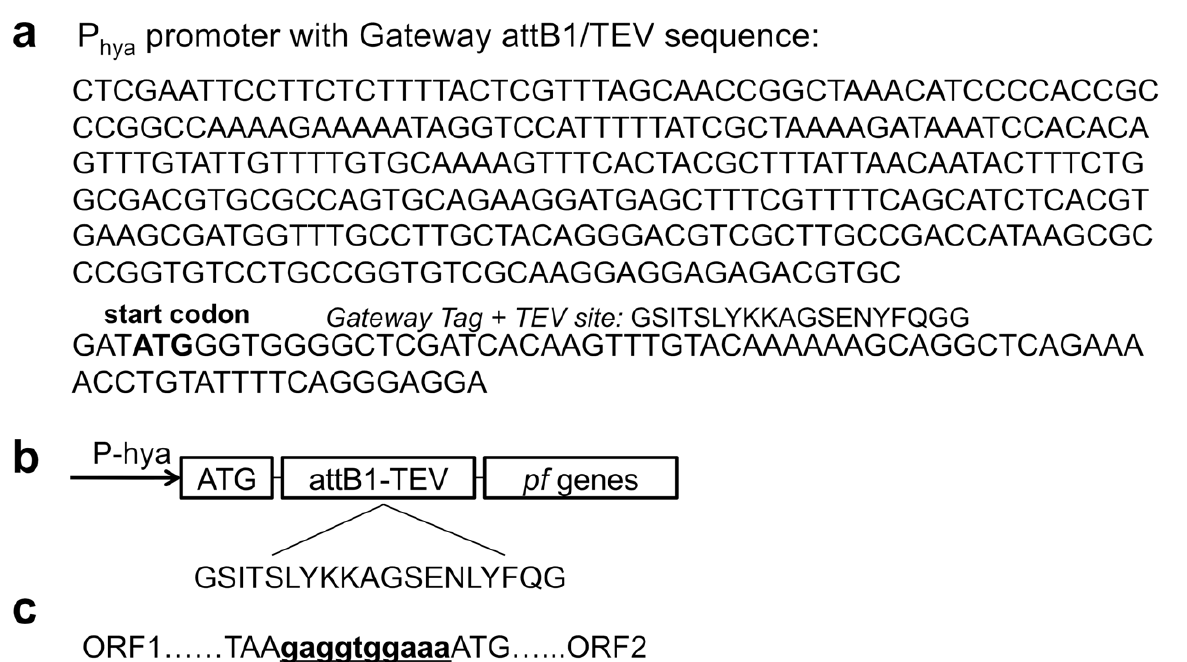
Figure 3. Plasmid construction for rSHI production in E.coli . P hya was cloned into a set of patented plasmids constructed by inserting Invitrogen Gateway cassettes into Novagen Duet plasmids [25]. ( a ) Sequences of E. coli anaerobic promoter P hya , attB1 and TEV protease recognition site sequence and their encoded peptide sequence [31]. ( b ) Elements constructed in the final expression plasmids: P hya promoter, N-terminus of the first protein in the operon derived from the Gateway recombination cloning site (attB1) including a TEV protease site [31] and P. furiosus genes. ( c ) Artificial Shine-Dalgarno sequences inserted between P. furiosus fused ORFs in plasmids pC11A2-CDABI, pC3AR2-SdFa and pRA2-EF.